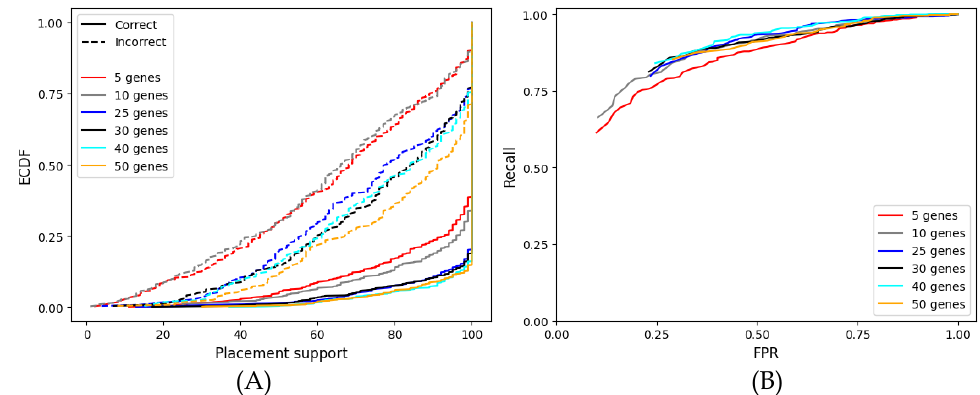
Figure A2. Evaluation of the fast bootstrapping support values for the placements on the species tree, with varying numbers of genes on the WOL multi-gene dataset. Each figure shows the results obtained from the concatenation of the best 5, 10, 25, 30, 40, and 50 genes. ( A ) Empirical cumulative distribution function (ECDF) plot of the support values, showing the percentage of the correct/incorrect placements (shown in the y -axis) at or below specified placement support levels (in the x -axis). ( B ) ROC curves, built using a range of 0–100 support thresholds, showing the predictive power resulting from the concatenation of various numbers of genes. Here, the same data as those used in Figure A1 are used.